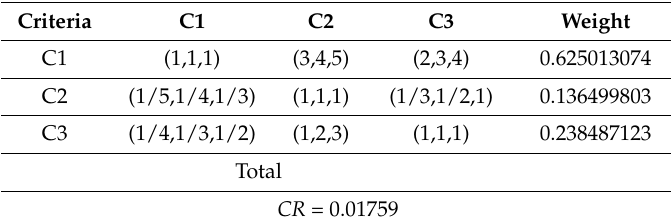
Table 8. Comparison matrix for C.